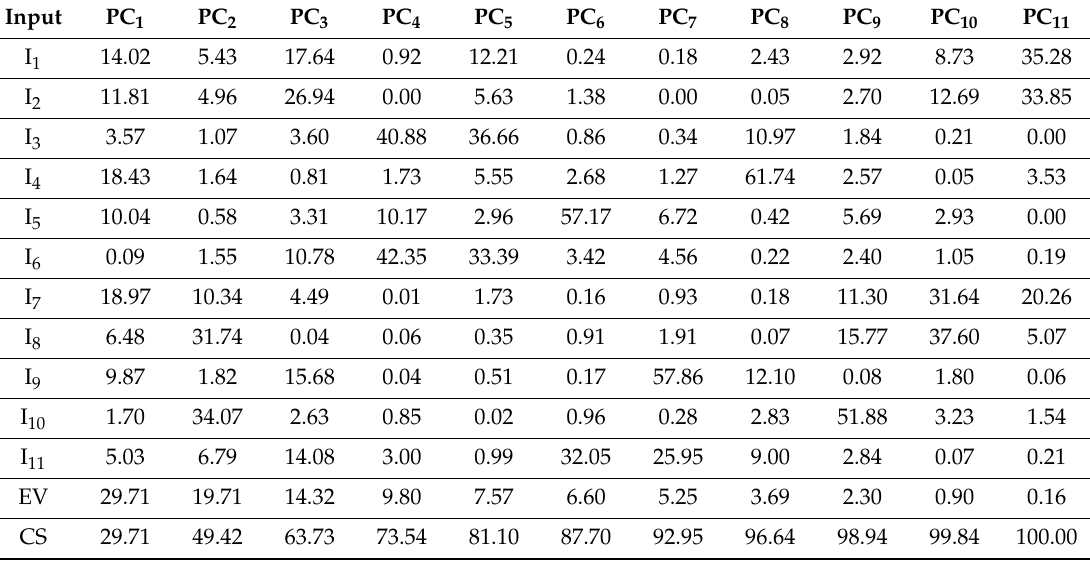
Table 2. Principal Component Analysis (PCA’s) results. Principal Component Analysis